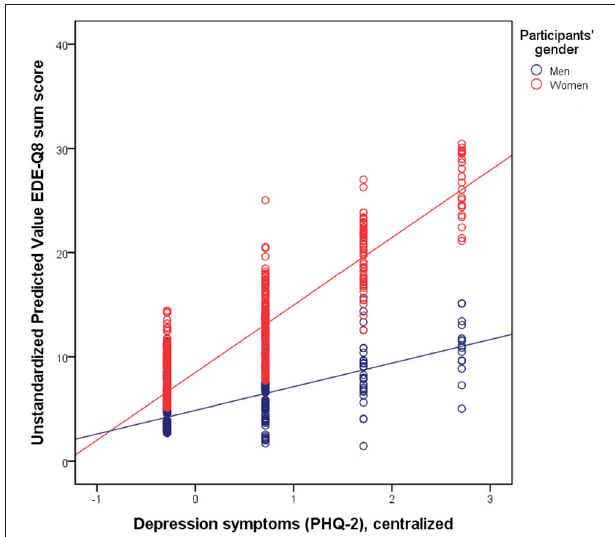
FIGURE 2 | Percentage of individuals of the general population who reported that the respective behavior had occurred at least four times over the course of the last month (stratified by gender). Asterisks indicate statistically significant differences.